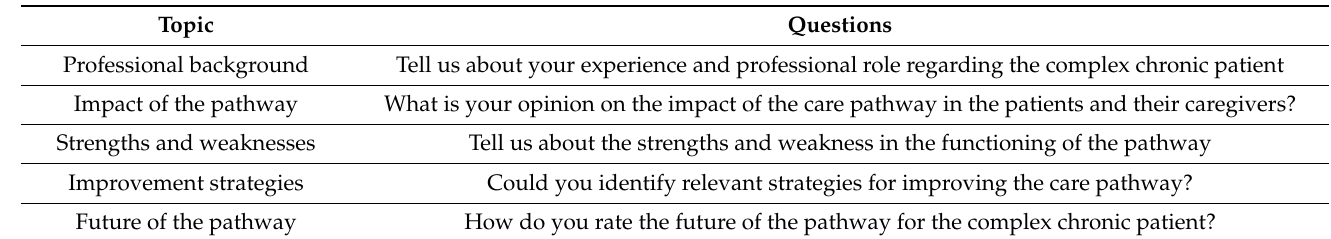
Table 1. Semi-structured interview